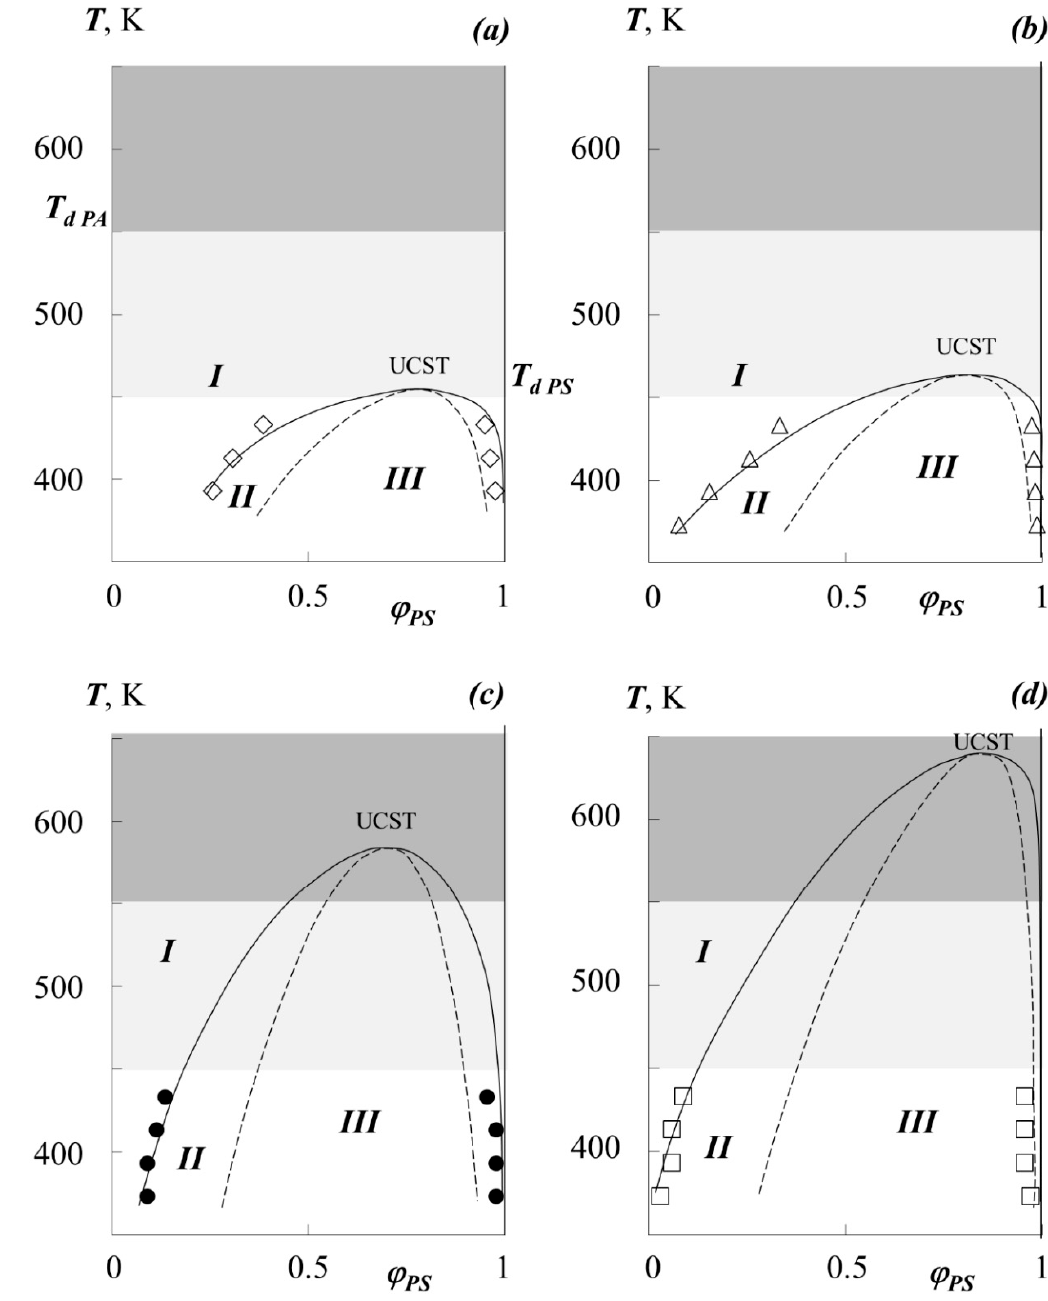
Figure 7. Simulation of phase state diagrams in the framework of the Flory–Huggins theory (see text for details) for the systems PEHA–PS-1 ( a ), PEA–PS-1 ( b ), PBA–PS-2 ( c ), PMA–PS-1 ( d ). Dots are experimental data, solid lines present binodal curves, dashed lines are spinodal curves, light gray area is the zone of thermal destruction of oligomeric polystyrene, dark gray area is the zone of thermal destruction of polyacrylates, I–region of homogeneous state, II–metastable region, III–labile structures region.